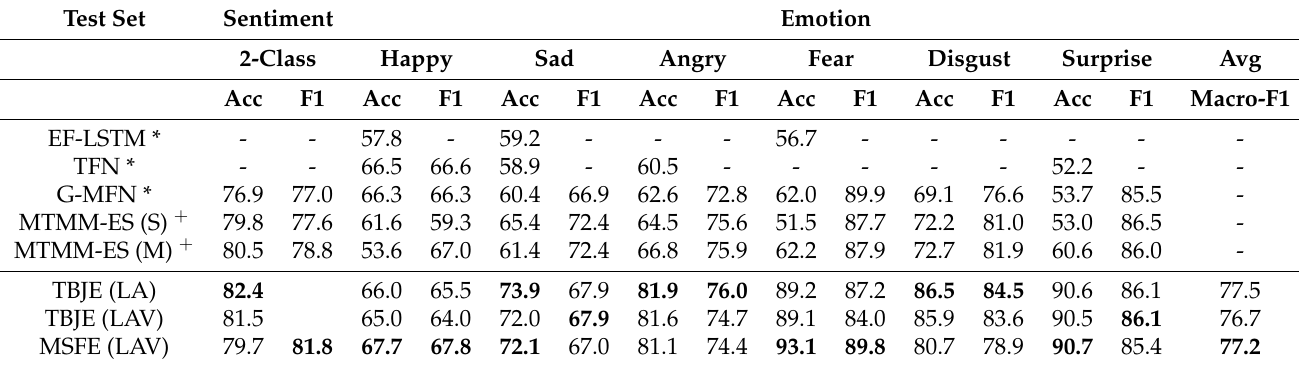
Table 3. Results on the test set. Please note that the F1 score and the binary classification accuracy of sentiment prediction are weighted to be consistent with the previous state-of-the-art technology. In the six categories of emotion labels, the F1 score is consistent with the previous technology, and the accuracy rate is the same as the latest technology TBJE, which is the standard accuracy rate. The Macro-f1 score is the average of the F1-score of six categories. * Values are taken from in [32] . + Values are taken from in [38]. Test